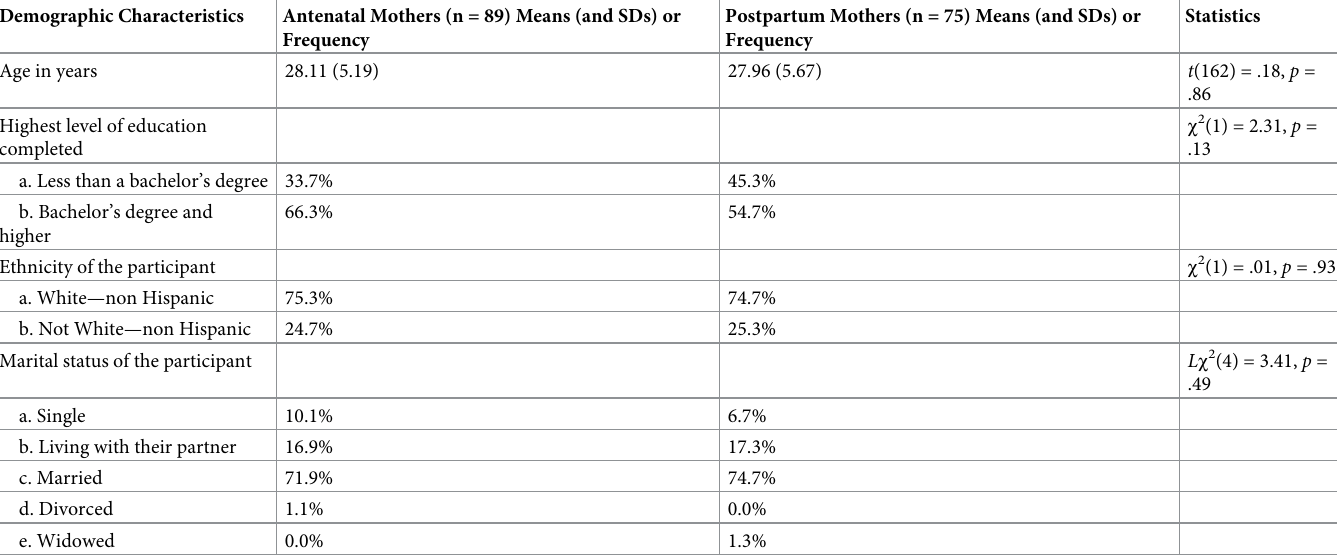
Table 2. Demographic characteristics of antenatal and postpartum mothers.